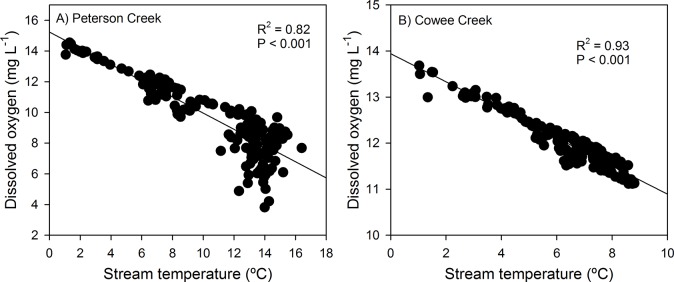
Regression models describing the relationship between mean daily stream temperature and mean daily DO in A) Peterson Creek and B) Cowee Creek during the 1 May through 31 October, 2013 study period.